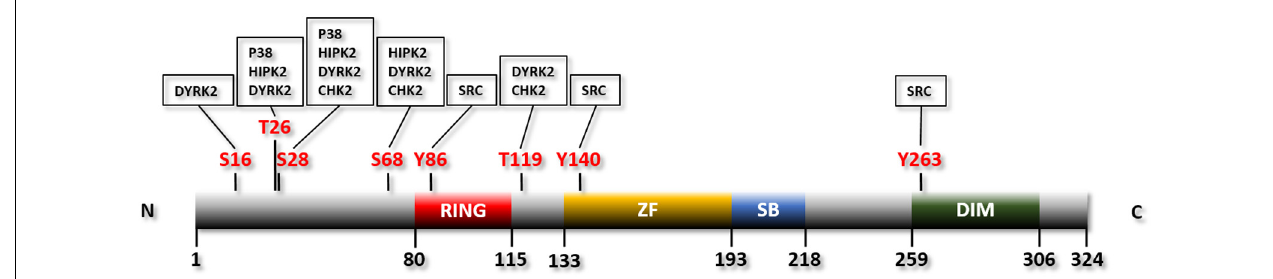
FIGURE 1 | Linear structure of human SIAH2 with the phosphorylation residues and the protein kinases indicated. RING, RING finger domain; ZF, zinc finger domain; SB, substrate binding domain; DIM, dimerization domain.